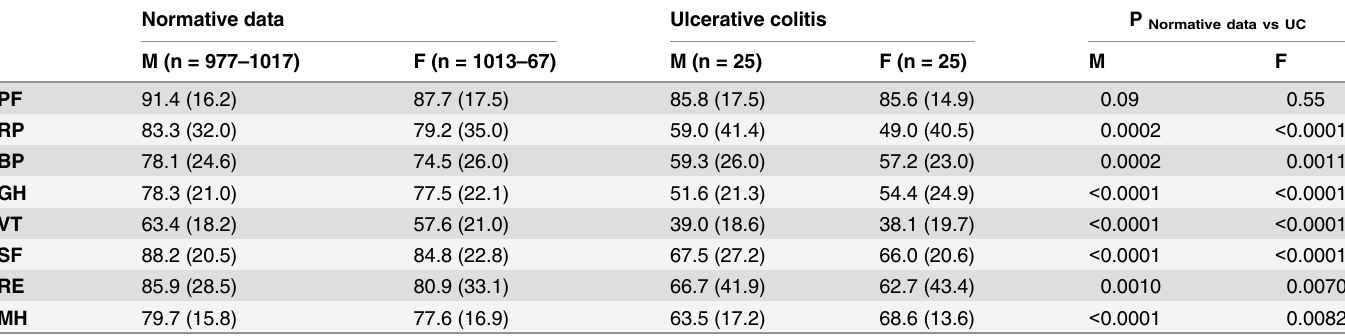
Table 5. Mean SF-36 scale scores. Age-adjusted Normative Data from the Norwegian Population compared with patients with UC on inclusion. Normative